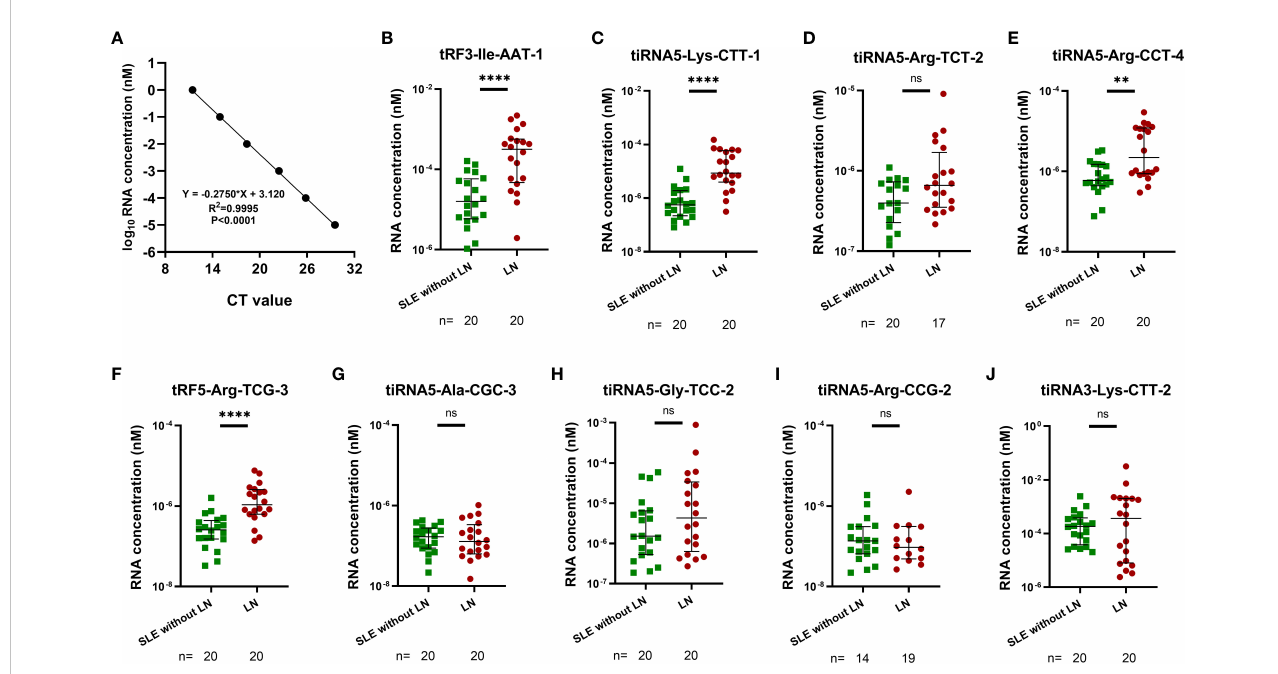
FIGURE 4 Identi fi cation of differentially expressed urinary exosomes derived tsRNAs in LNs and SLE without LN patients. (A) Linear standard curve of urinary exosomes derived tsRNAs concentration. (B – J) Differential expression of 9 tsRNAs veri fi ed by RT-qPCR in LN and SLE without LN patients. tRF3-Ile-AAT- 1, tiRNA5-Lys-CTT-1, tiRNA5-Arg-CCT-4 and tRF5-Arg-TCG-3 were signi fi cantly upregulated in LNs compared with SLE without LN patients. P value of Mann Whitney U test: (**P < 0.01, ****P <